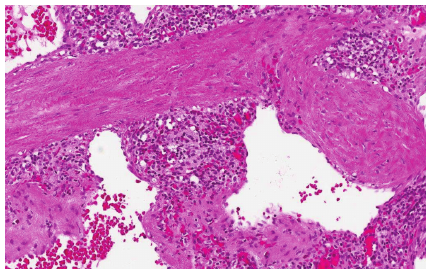
Figure 2: Photomicrograph × 20 magnification. Littoral cell angi- oma of the spleen composed of small anastomosing and irregular channels reminiscent of splenic sinuses and covered of neoplastic plump “littoral” cells with low mitotic activity.